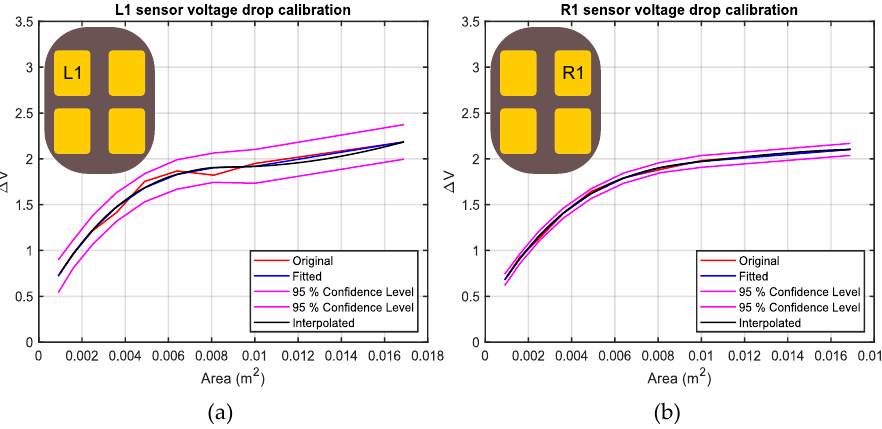
Figure 11. Calibrated voltage drop curve for L1 and R1: ( a ) L1 sensor; ( b ) R1 sensor.